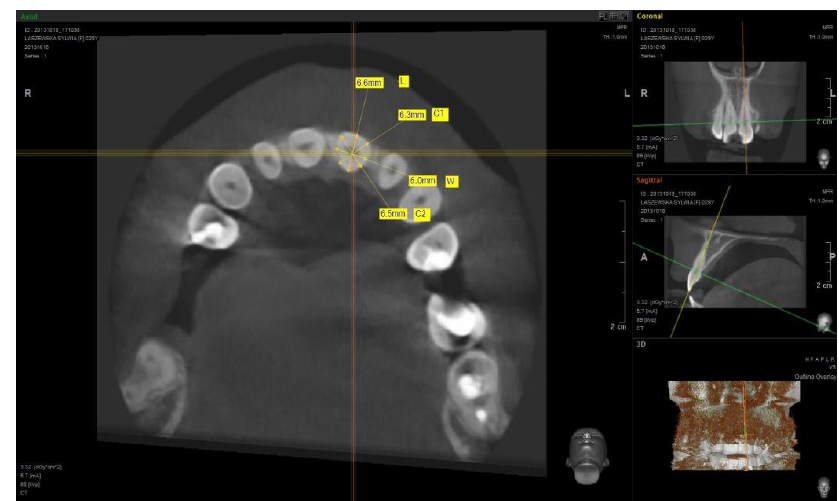
Figure 1. Example of a measurement of the central incisor cross-section.